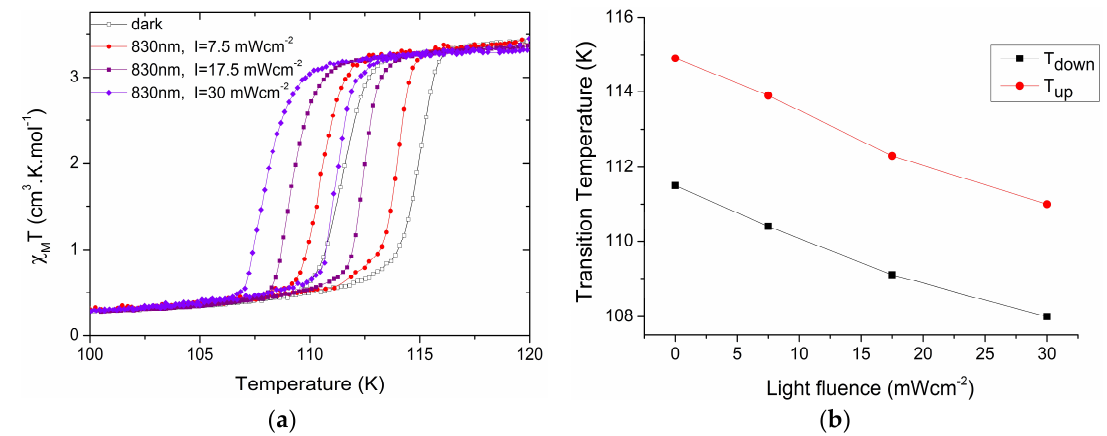
Figure 3. ( a ) Thermal dependence of the magnetic moment ( χ m T ) under various light irradiation intensities, given in the figure, showing a significant shift of the thermal hysteresis to low-temperature regions. ( b ) Light intensity dependence of the upper and lower transition temperatures of the thermal hysteresis.